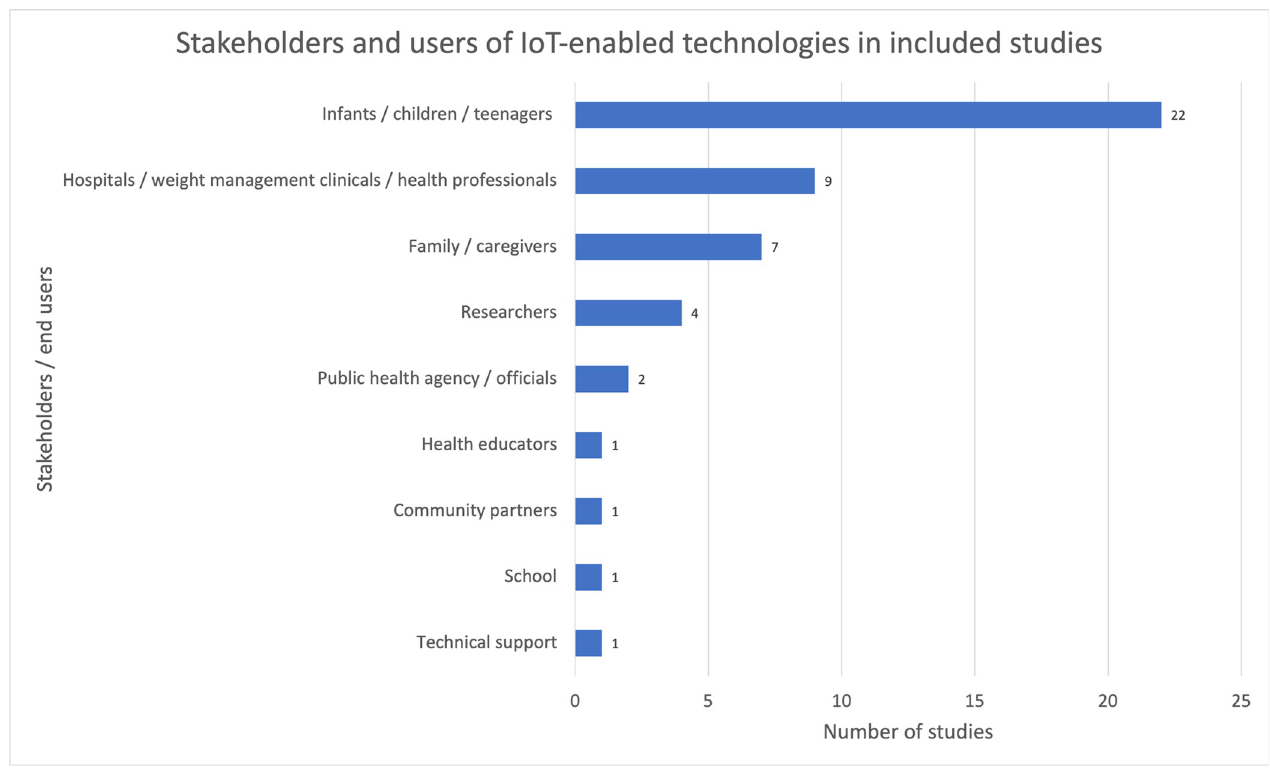
Fig 7. Stakeholders and users of IoT-enabled technologies in included studies (number in bracket indicates the number of studies which considered the stakeholder).